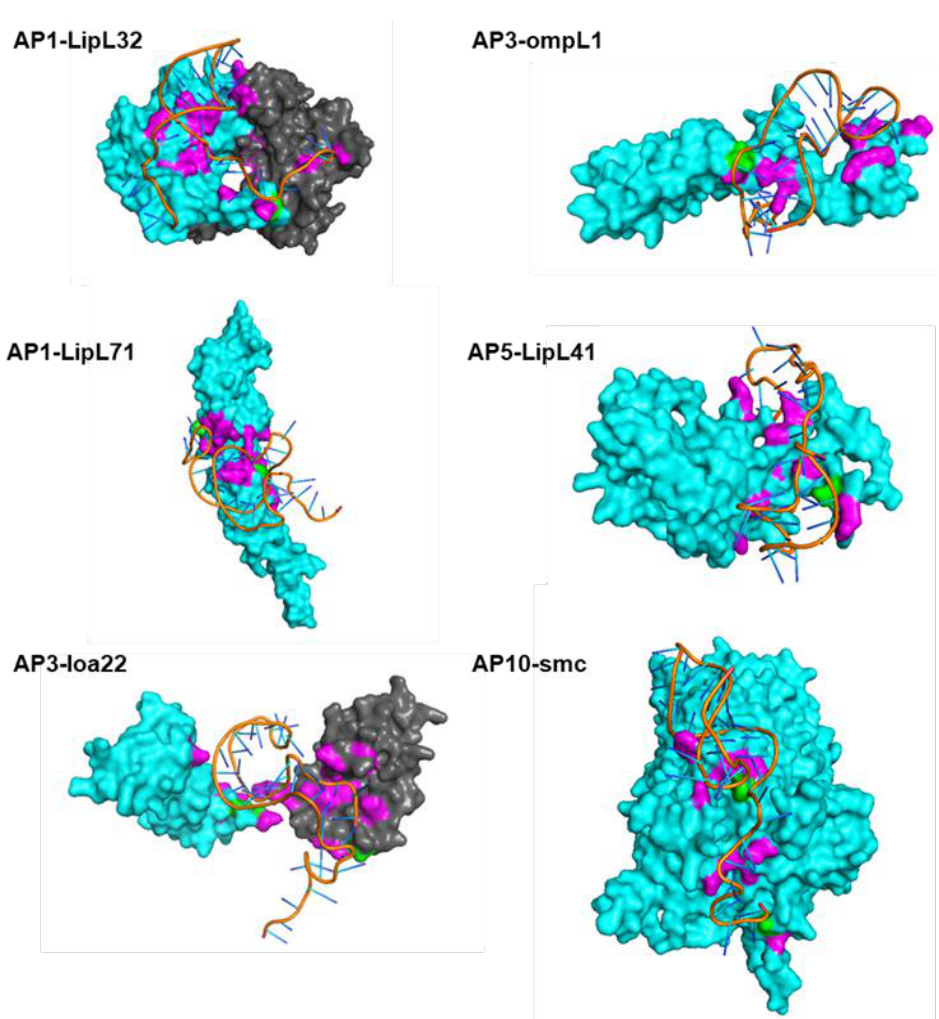
Figure 4. Predicted binding sites of aptamers with the highest number of interactions to six selected target proteins, using HDOCK and visualized through PyMOL. Simulated aptamer – protein complexes show hydrogen bonds in pink and hydrophobic interactions in green.